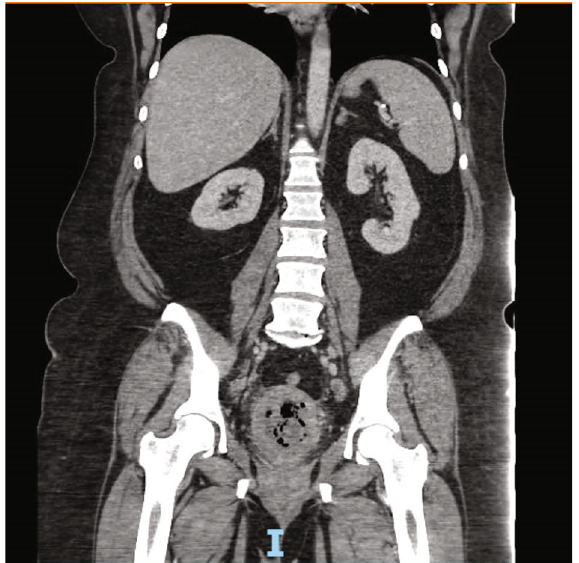
Figure 2: CT scan with contrast at time of presentation to the emergency department. Gas fl uid collection was noted to measure up to 13cm in length, 6 cm in width, and 5cm in height. Findings concerning for